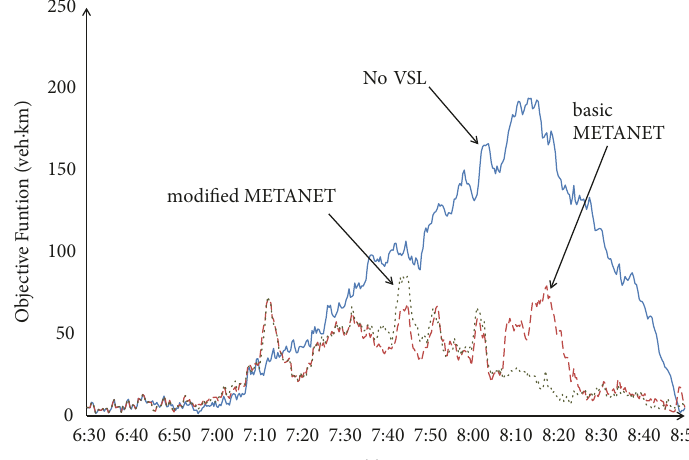
Figure 8: Comparison of the objective function for No VSL, basic, and modified METANET-VSL controls.